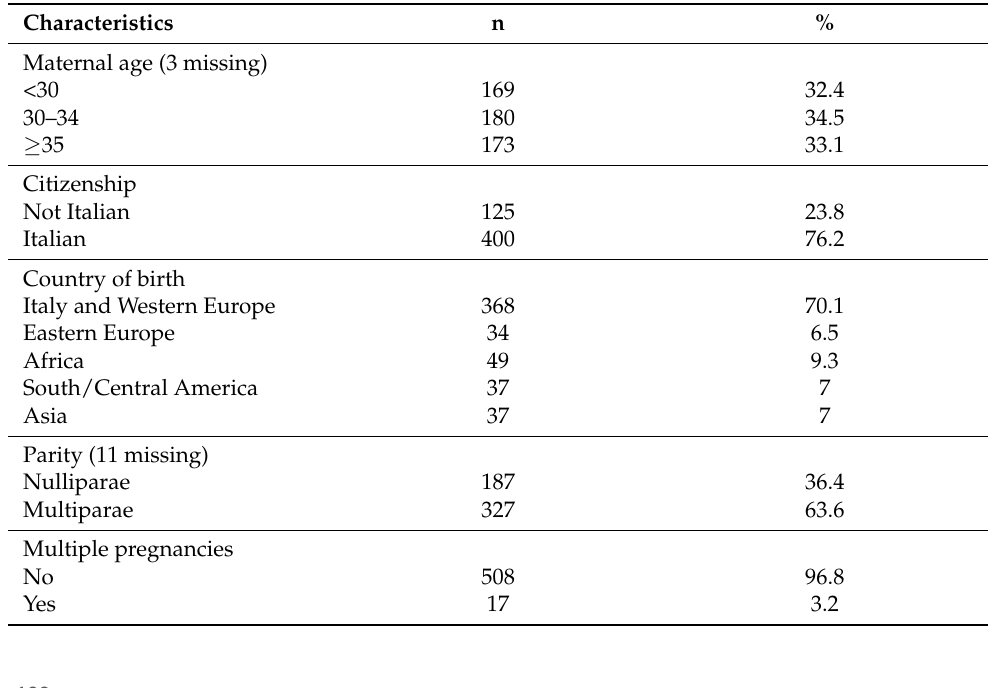
Table 1. Women’s socio-demographic and obstetric characteristics ( n = 525).